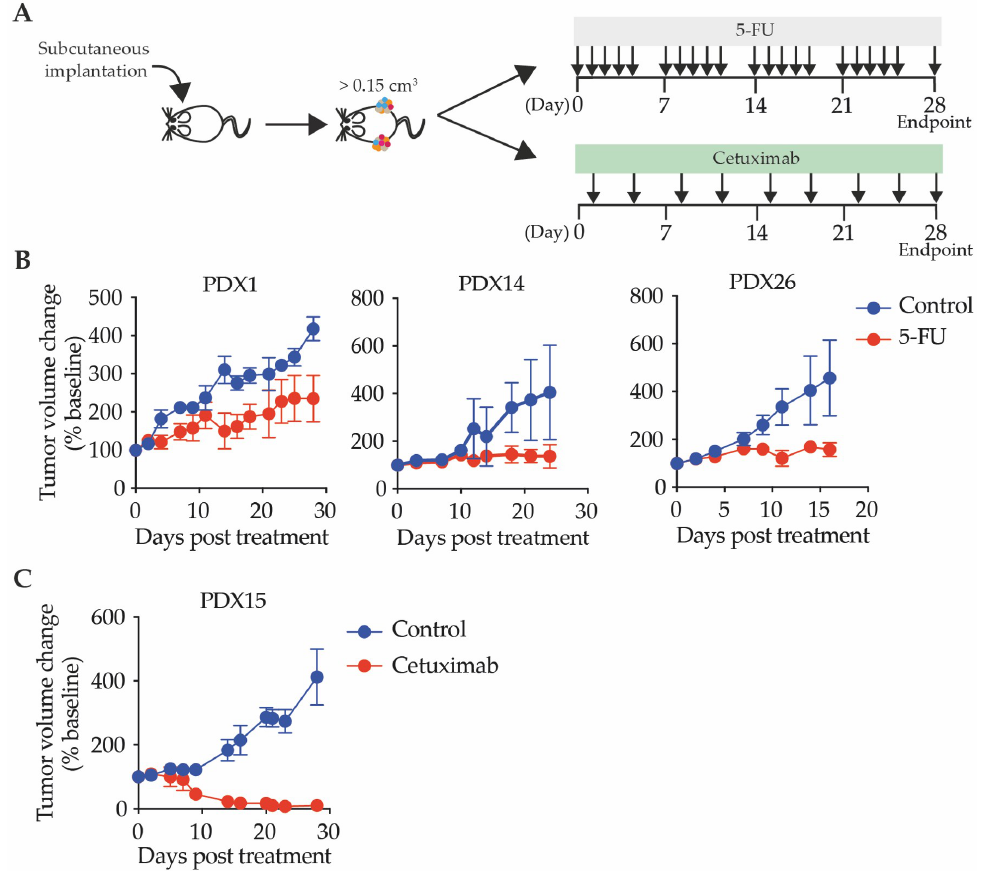
Figure 6. Treatment of patient-derived xenografts. ( A ) Schematic representation of treatment protocols; ( B ) tumor volume following treatment with 10 m / kg 5-FU for PDX1 or 15 mg / kg for PDX14 and PDX26; and ( C ) tumor volume following treatment with cetuximab 20 mg / kg. Data are represented as mean ± SEM with at least two mice per passage, with two tumors per mouse.